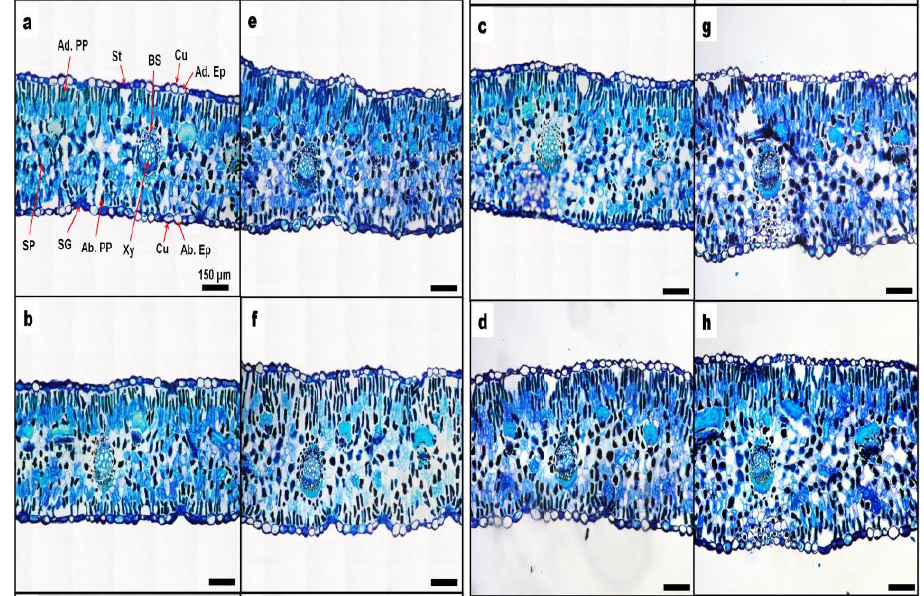
Figure 2. Cross-section showing anatomical changes in the aerial part of L. guyonianum subjected to monthly variations of climatic conditions in Ain Maider Sabkha (( a ) = January, ( b ) = February, ( c ) = March, ( d ) = April, ( e ) = May, ( f ) = June, ( g ) = July and ( h ) = August). Bars = 1500 µm. Ab. Ep, Abaxial epidermis; Ab. PP, abaxial palisade parenchyma; Ad. Ep, Adaxial epidermis; Ad. PP, adaxial palisadeparenchyma; BS, bundle sheath; Cu, cuticle; SP, spongy parenchyma; SG, salt gland; St, stomata; Xy, xylem.